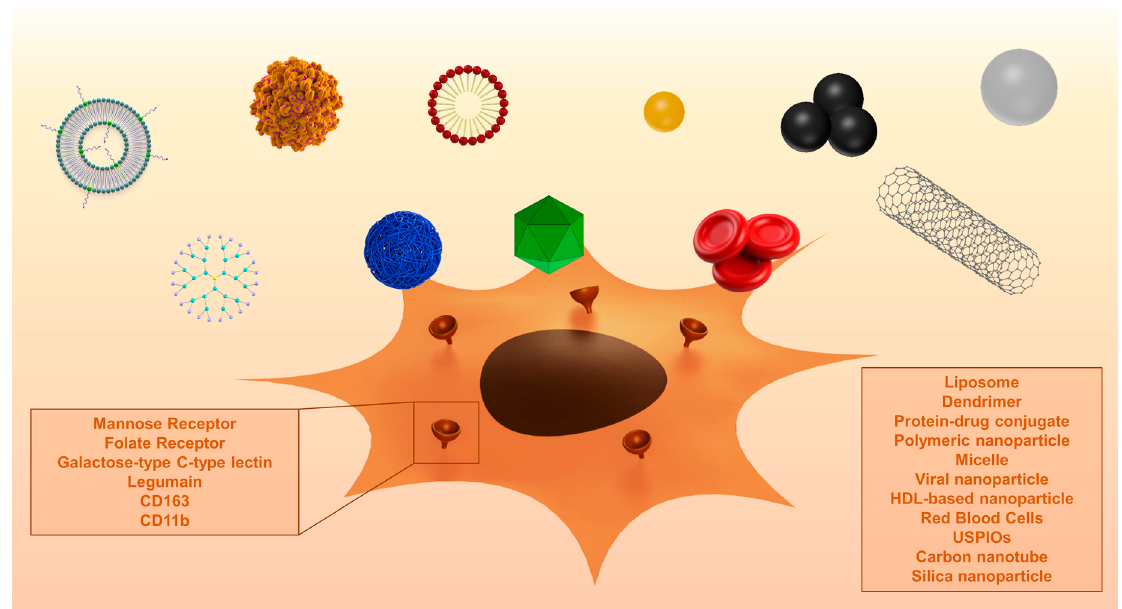
Figure 2. Graphical presentation of surface proteins and different nanoparticles used in TAM targeting. Names of nanoparticles are displayed in their order of appearance, left to right. Abbreviations: HDL: High density lipoproteins, CD: cluster of differentiation, USPIO: ultrasmall superparamagnetic iron